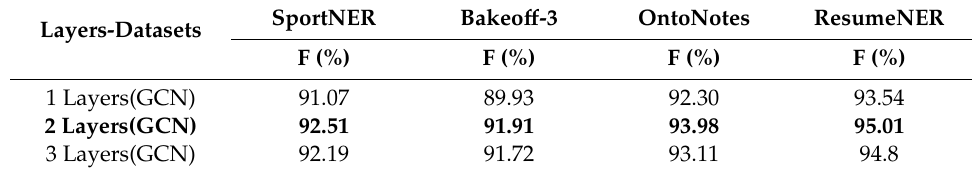
Table 8. E ff ect of the di ff erent graph convolutional network (GCN) layers on the model performance.